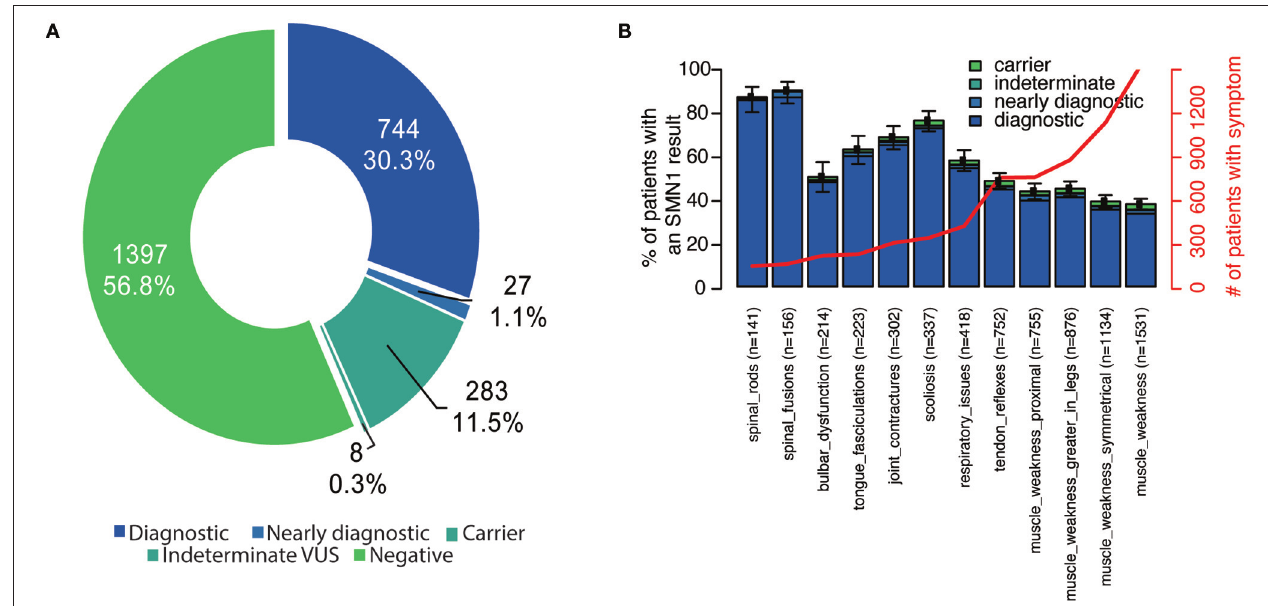
FIGURE 1 | Diagnostic yield and reported clinical features among unrelated individuals in the SMA Identified program. (A) Individuals were stratified according to their genetic testing result. Diagnostic indicates that the individual had two P/LP SMN1 variants in trans (homozygous deletion or compound heterozygous P/LP). Nearly diagnostic individuals had a heterozygous deletion of SMN1 in combination with either a VUS unambiguously in SMN1 or an ambiguous variant in SMN1 or SMN2 . Indeterminate VUS results were defined as one VUS. Carriers were heterozygous for the SMN1 deletion. Those categorized as negative had no P/LP SMN1 or SMN2 variants detected (even if they had a P/LP variant in another gene if tested through a multi-gene panel). (B) For each clinician-reported clinical feature, the proportion of individuals with the symptom was also calculated (number of individuals indicated in x-axis and red line). Those with a negative result represent the remaining space above each stacked bar. Bar indicates 95% confidence interval for each clinical feature. P/LP, pathogenic/likely pathogenic; SMA, spinal muscular atrophy; VUS, variant of uncertain